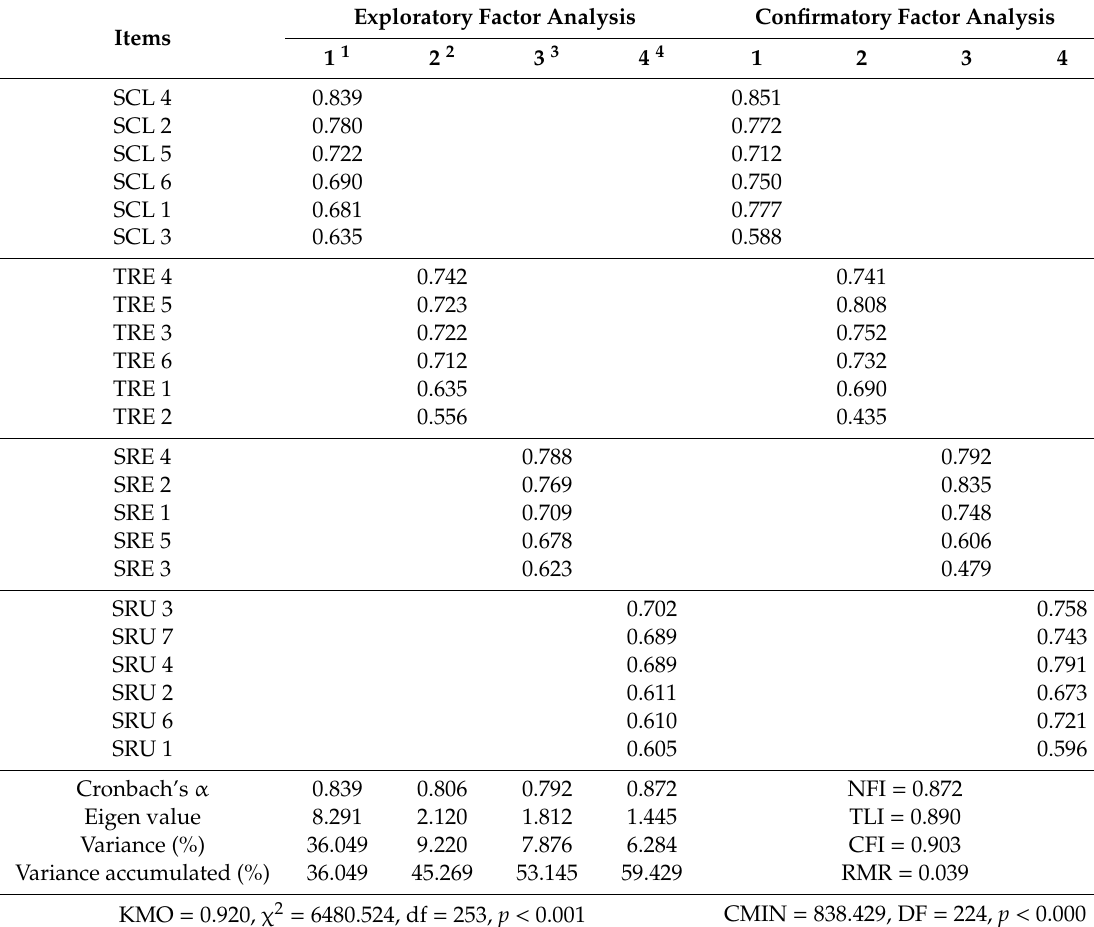
Table 2. Results of Exploratory and Confirmatory Factor Analysis for School Adjustment Scale. Exploratory Factor Analysis Confirmatory Factor Items